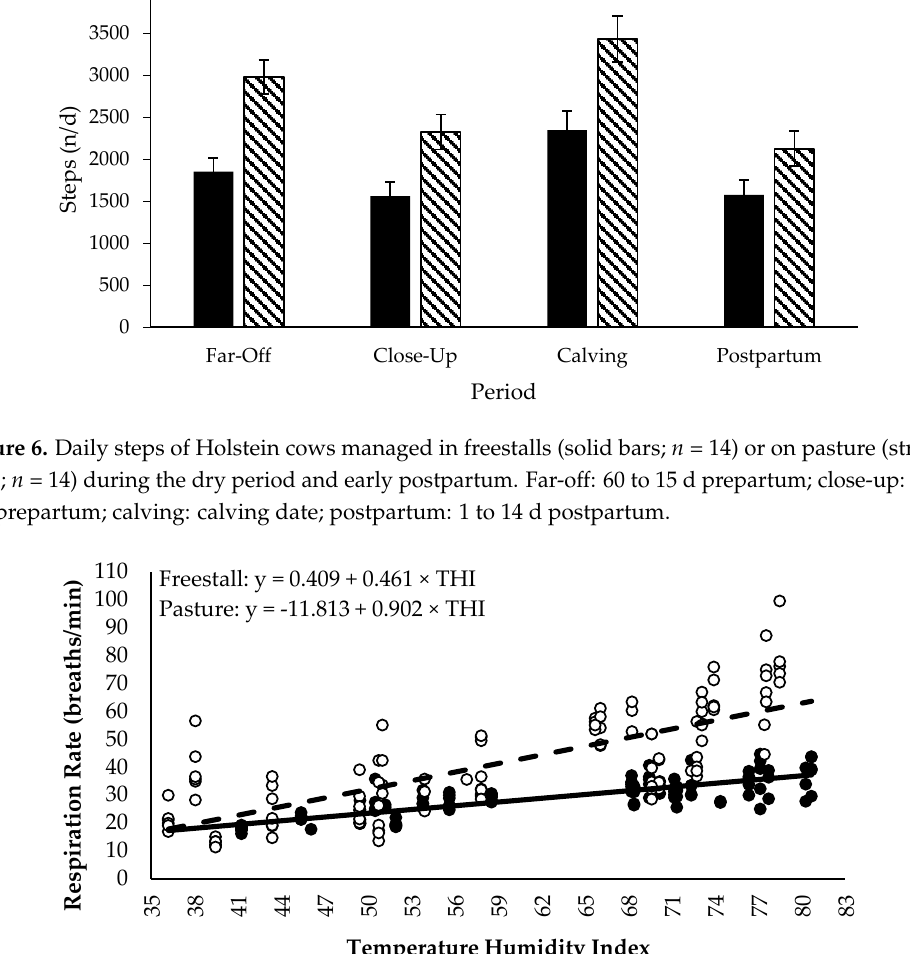
to 1 d prepartum; calving: calving date; postpartum: 1 to 14 d postpartum.